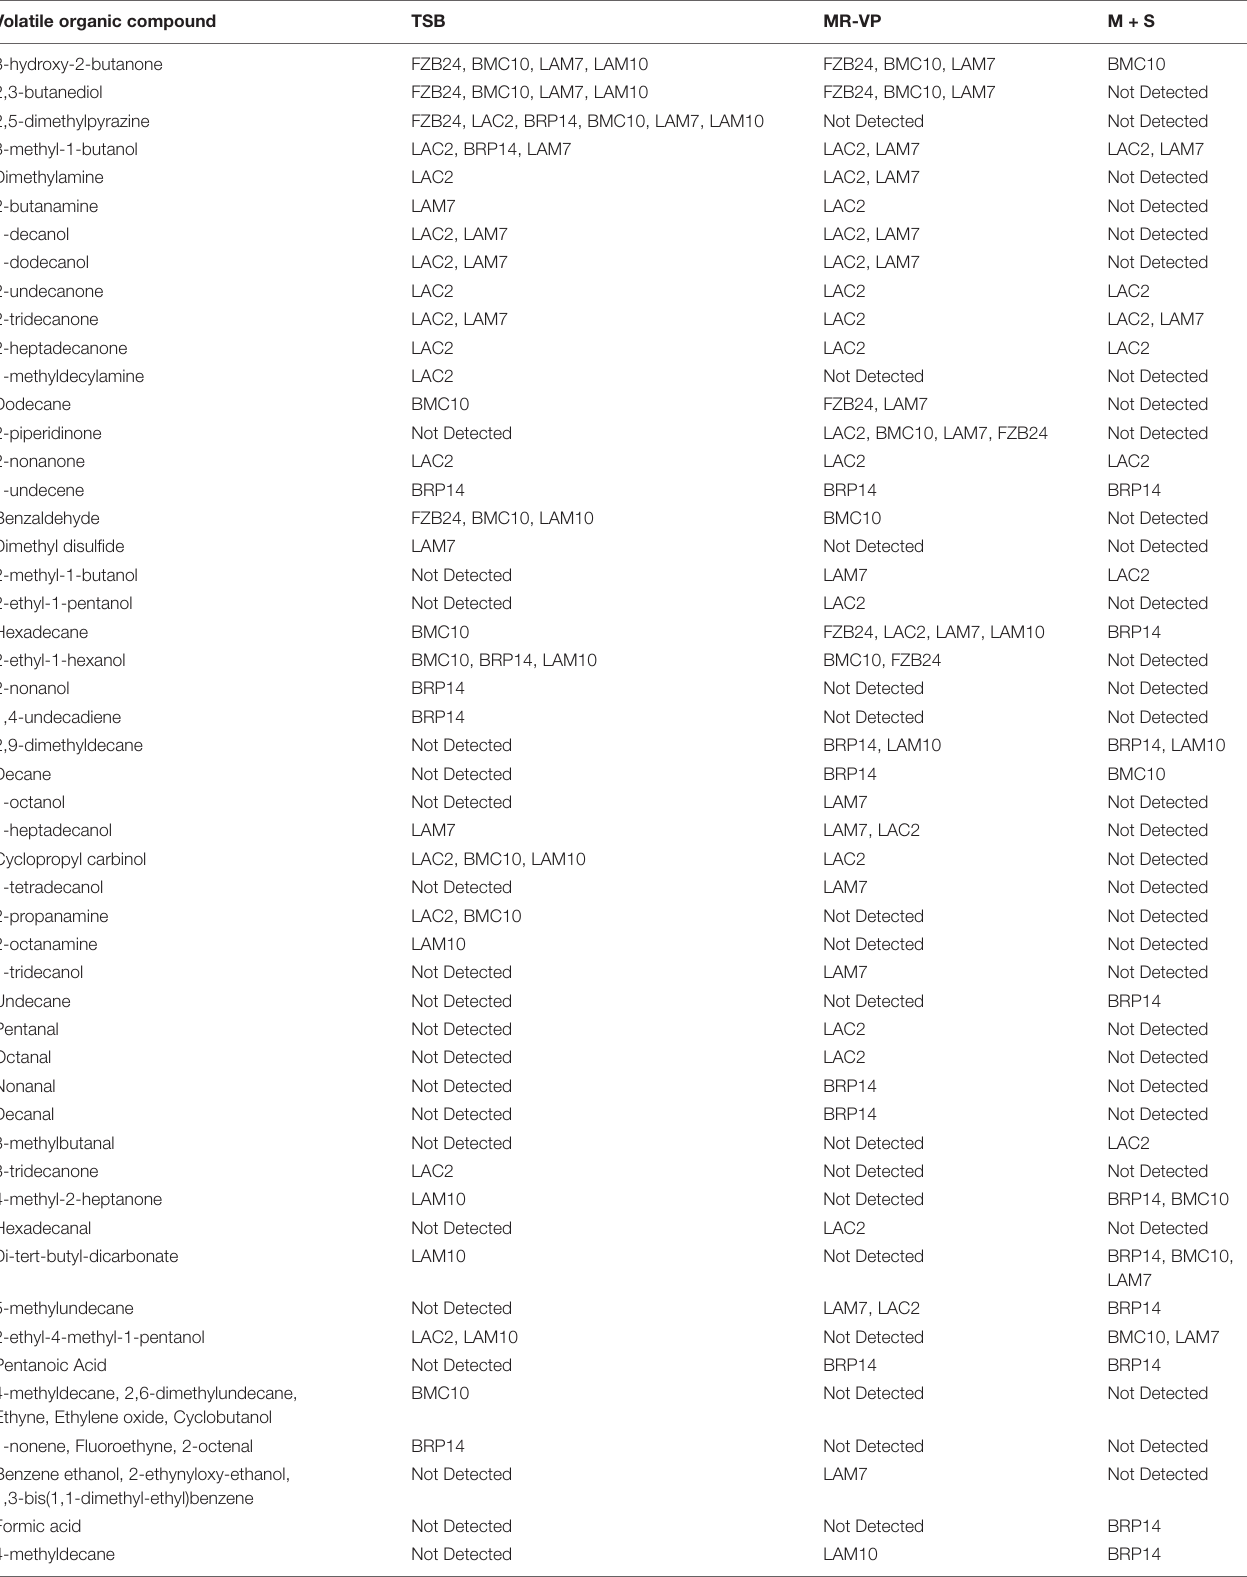
TABLE 1 | Putative volatile organic compound production over 72 h from six bacterial isolates growing in tryptic soy broth (TSB), liquid MR-VP and liquid M + S. Volatile organic compound TSB MR-VP M +